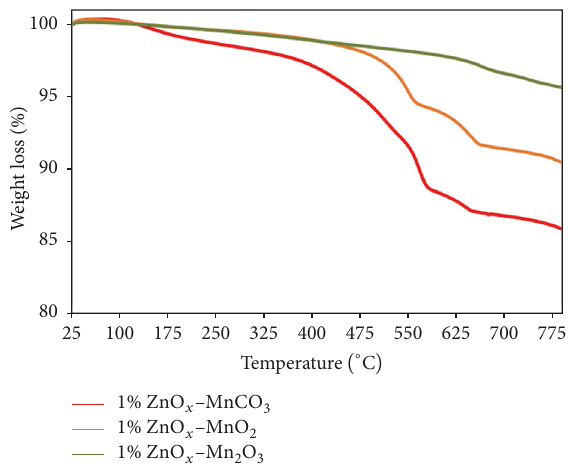
Figure 6: TGA of as-synthesized catalyst calcined at different calci- nation temperatures 300 ∘ C, 400 ∘ C, and 500 ∘ C; 1% ZnO